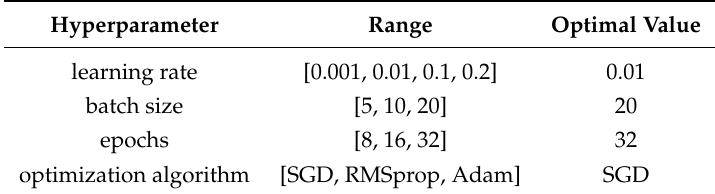
Table 2. The range and optimal values of hyperparameters for